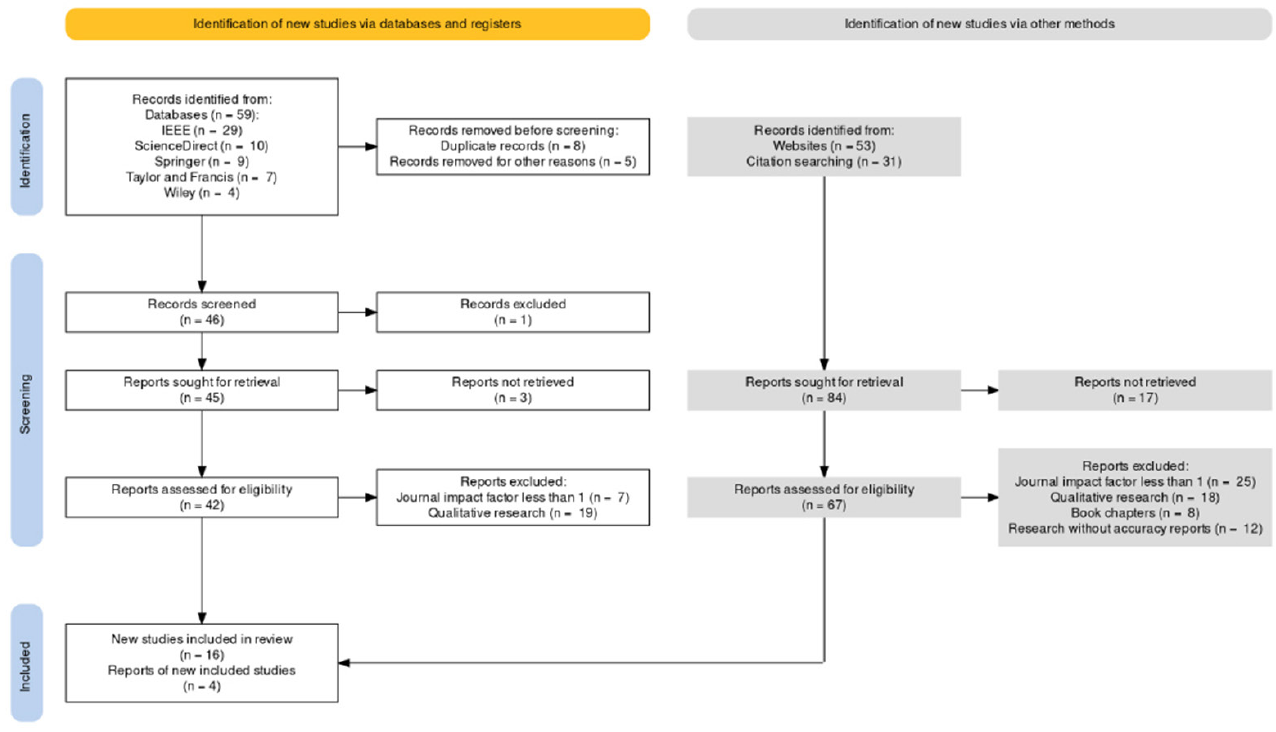
Fig. 1. Flowchart of the selection process